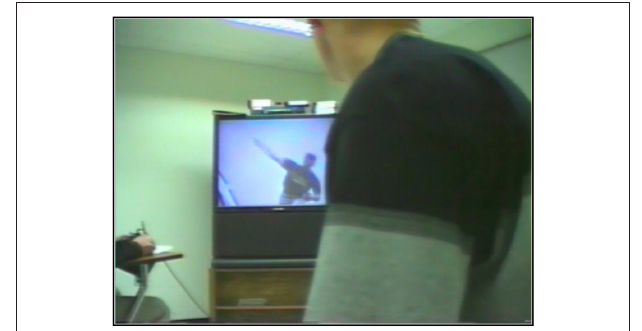
FIGURE 2 | Video-Occlusion in lab